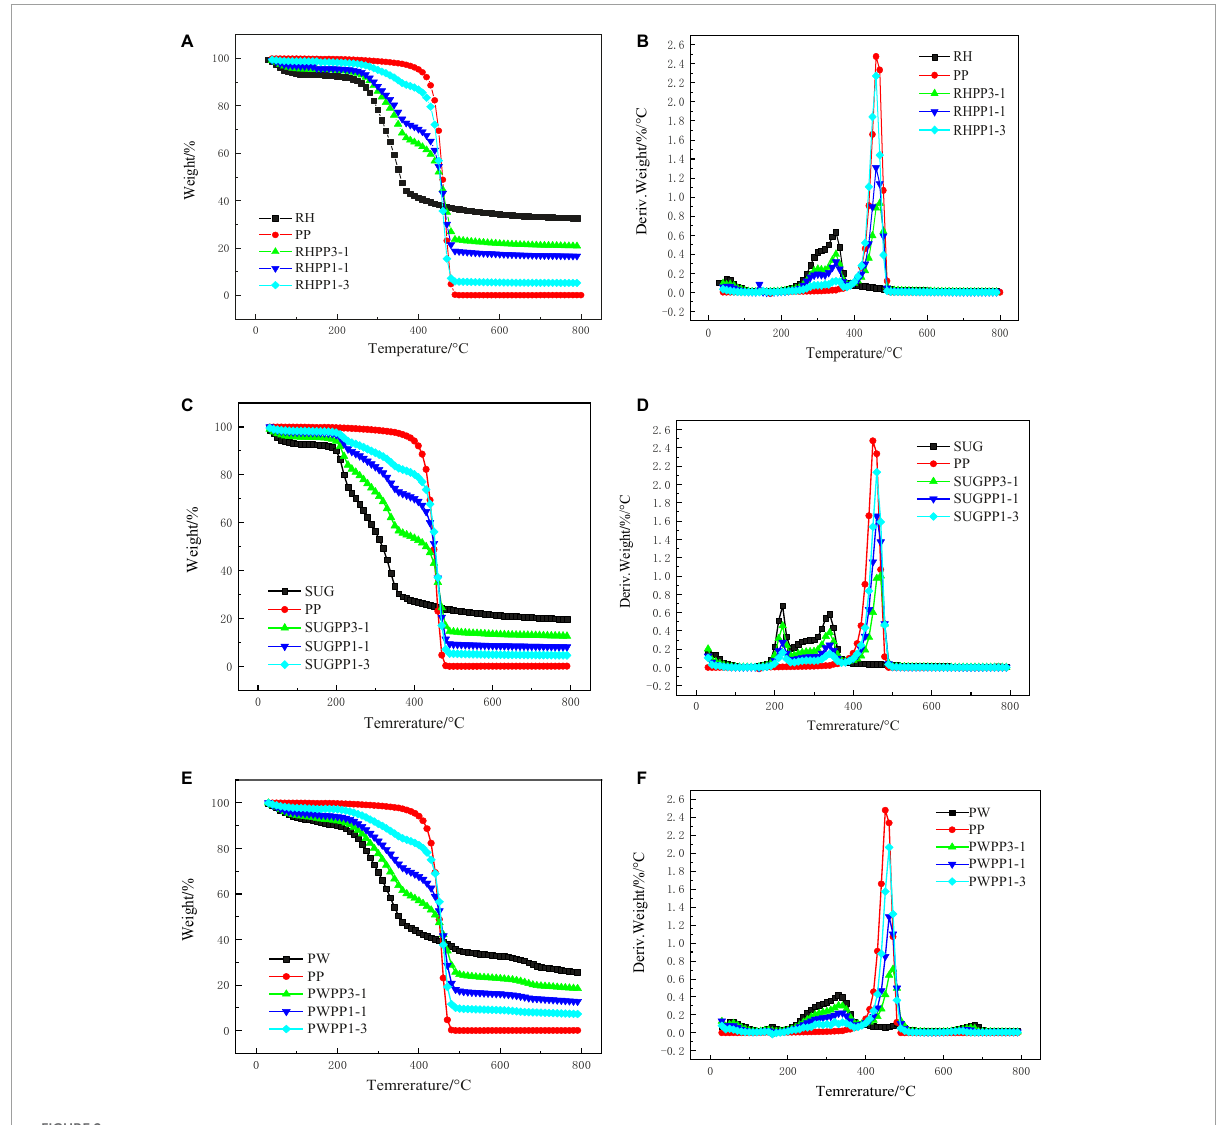
FIGURE2 Pyrolysis characteristics of the PP, RH, SUG, PW, and their mixtures in various mass ratios in TGA with heating rate of 10 ◦ C/min, (A) TG profiles of RHPP, (B) DTG profiles of RHPP, (C) TG profiles of SUGPP, (D) DTG profiles of SUGPP, (E) TG profiles of PWPP, and (F) DTG profiles of PWPP.